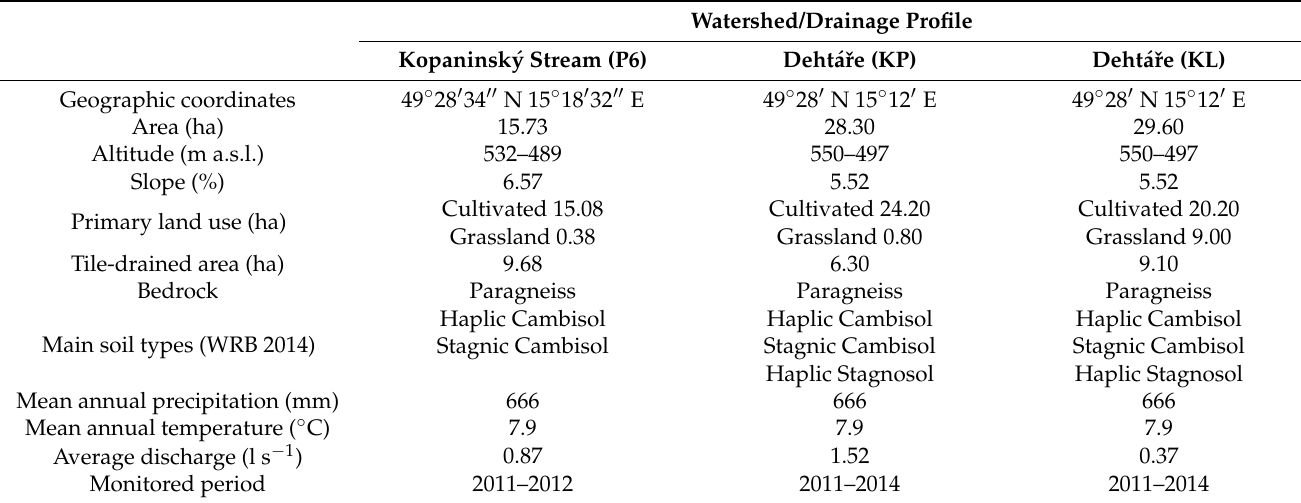
Table 1. Physical characteristics of the three small agricultural catchments